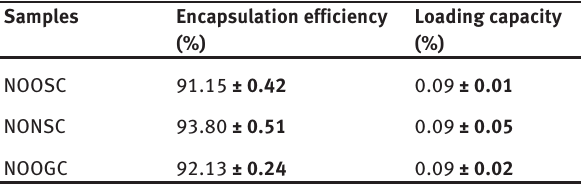
Figure 8: Solubility of chitosan, NOOSC, NONSC and NOOGC at pH 1.0 to 13.0. Values represent mean of three replicates ± standard deviation. Table 2 : The encapsulation efficiency and loading capacity of NOOSC, NONSC and